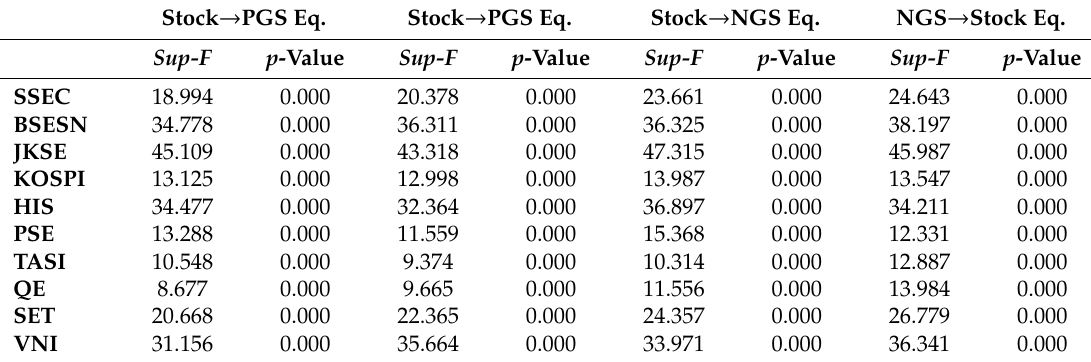
Table 5. Parameter stability